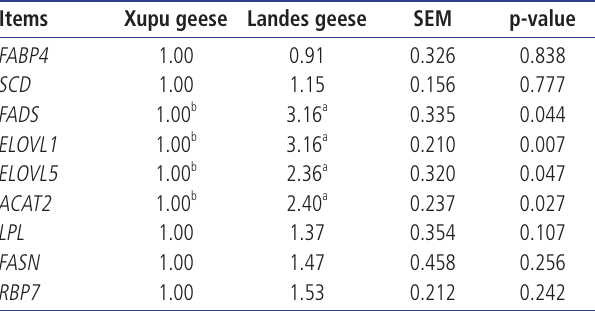
Table 7. Comparison of lipid metabolism related gene expressions in liver between overfed Xupu and Landes geese Items Xupu geese Landes geese